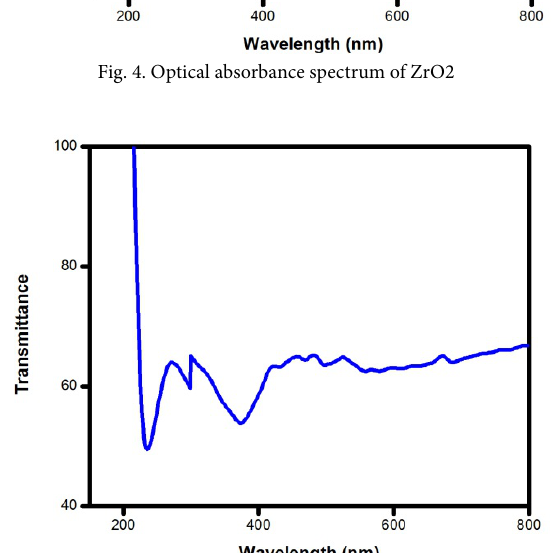
Fig. 5. Optical transmittance spectrum of